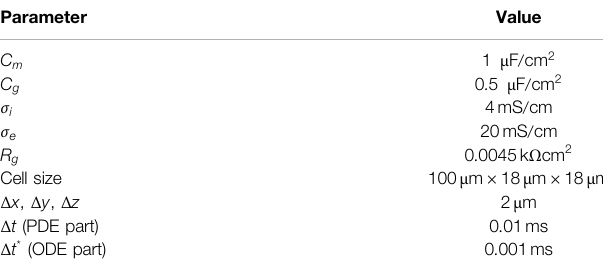
TABLE 1 | Default parameter values used in the simulations, based on Ref. 9.